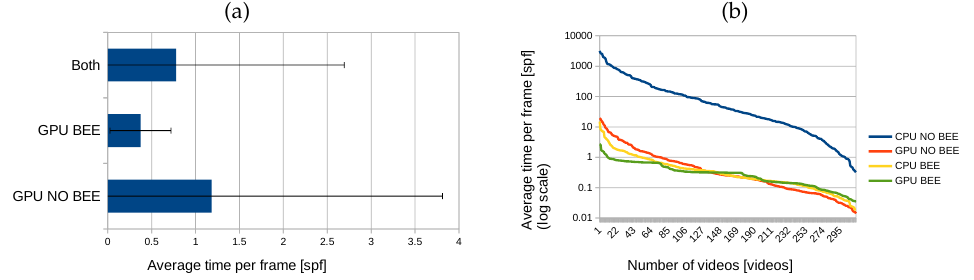
Figure 13. ( a ) Comparison of average time per frame between using parallel HSA (GPU BEE) or parallel exhaustive search (GPU NO BEE). ’Both’ shows the average and standard deviation of GPU NO BEE and GPU BEE combined. ( b ) Comparison of average seconds per frame survival curves between HSA (BEE) and exhaustive search (NO BEE). There are four survival curves, these are also marked as sequential (CPU) or parallel